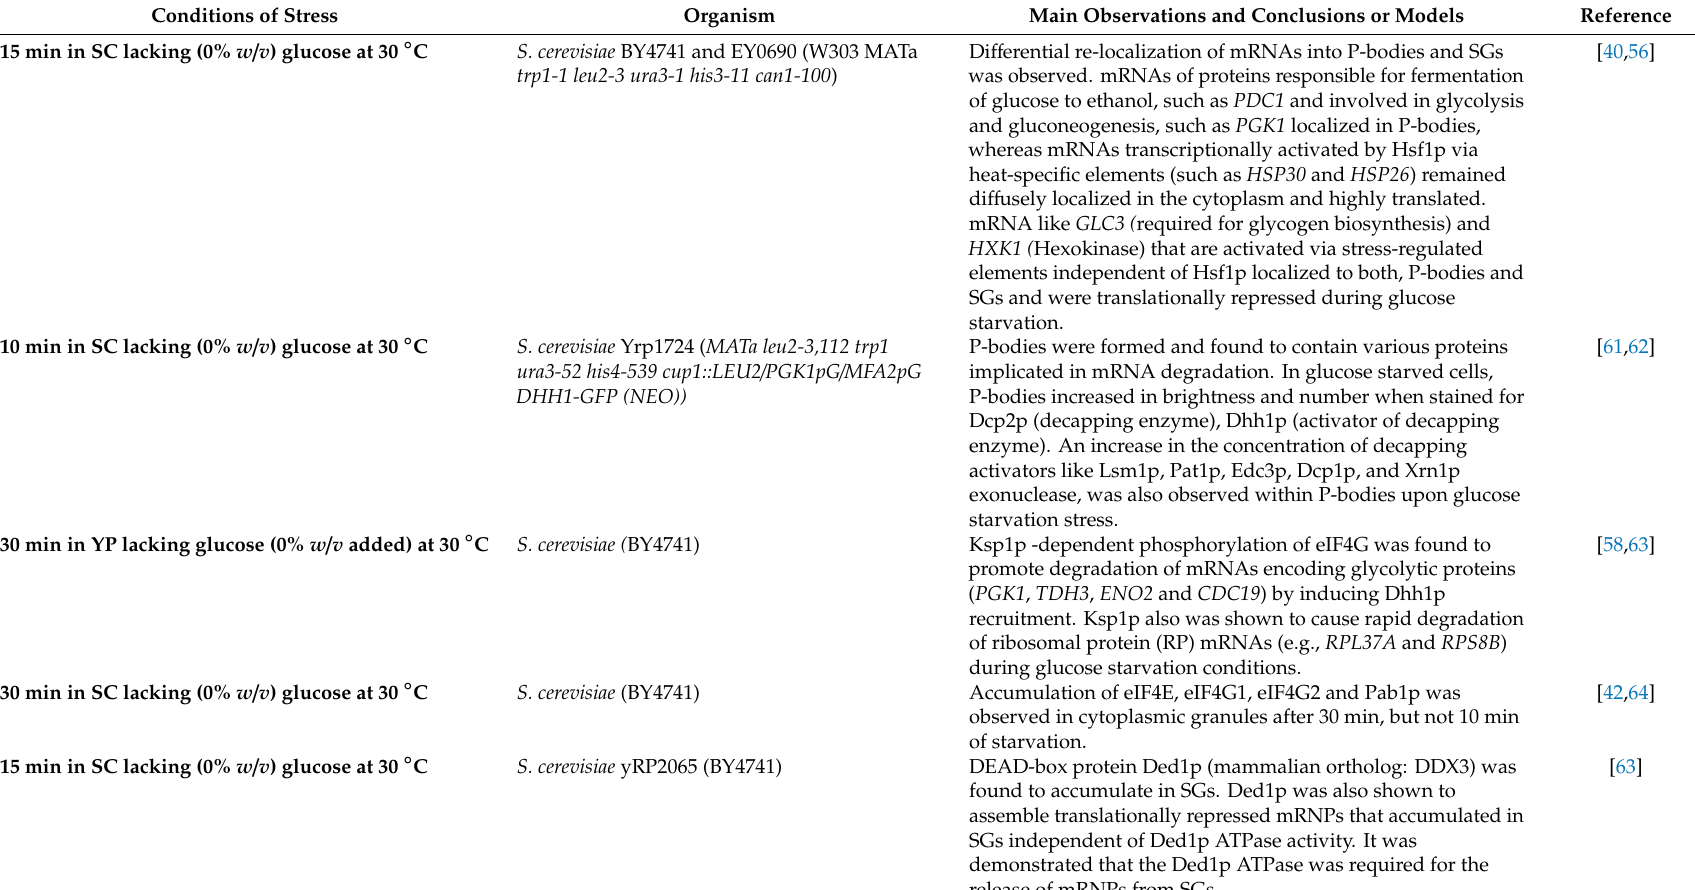
Table 5. Re-localization of mRNAs and translation factors into cytoplasmic granules and degradation of mRNAs during glucose starvation